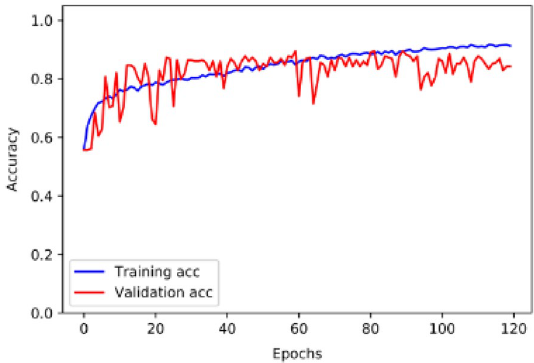
Fig. 7 Direct training